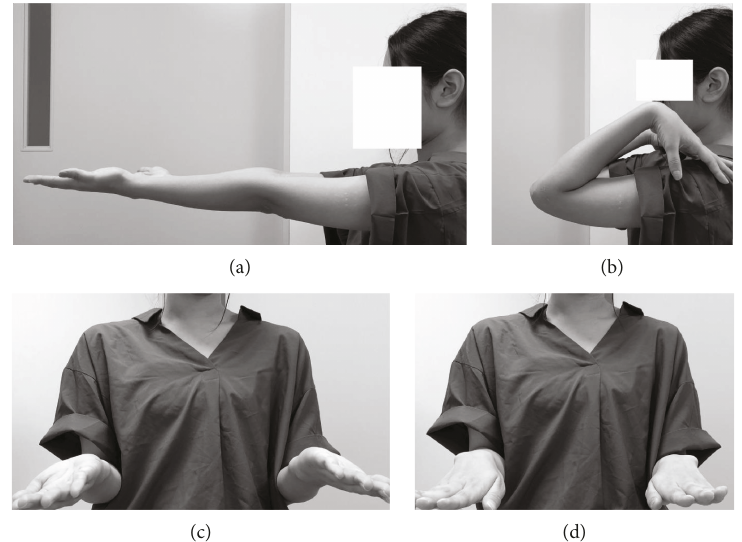
Figure 6: Ranges of motion at one-year follow-up. Elbow extension (a) and fl exion (b). Forearm supination (c) and pronation